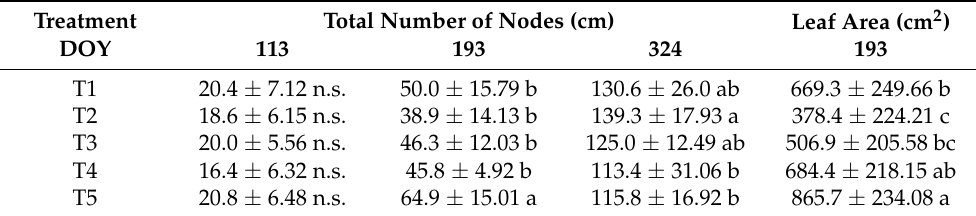
Table 4. Total number of nodes per plant and estimated leaf area in the compared treatments. Means followed by the same letter do not significantly differ at p < 0.05. Total number of nodes and leaf area. DOY = day of year. Data are reported as mean values ( n = 12) ± SD, n.s. = not significant. Treatment Total Number of Nodes